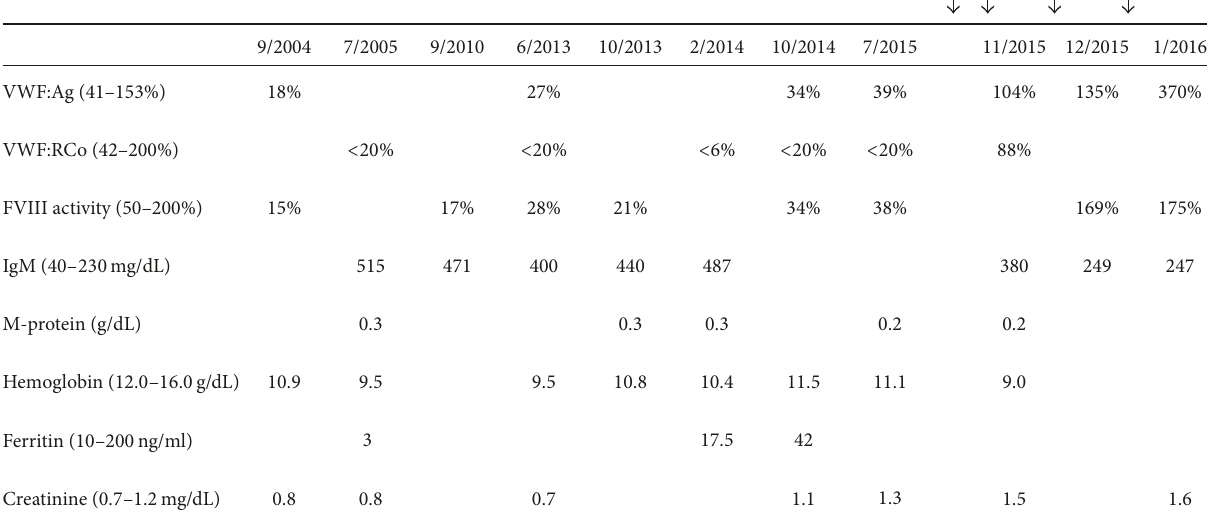
Figure 1: Laboratory response of AVWS after treatment of lymphoplasmacytic lymphoma with carfilzomib, rituximab, and dexamethasone. Arrows indicate cycles of treatment. Treatment resulted in normalization of VWF antigen level (VWF:Ag), VWF activity (VWF:RCo), and factor VIII activity assay (FVIII activity). Normal values are shown in